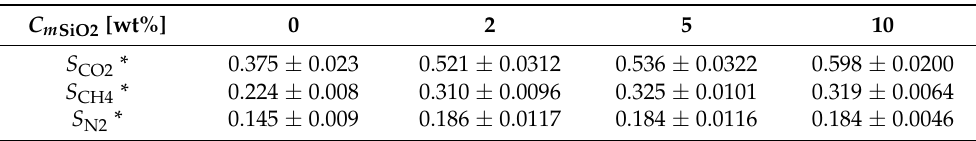
Table A7. Solubility coefficient S i for membranes of different SiO 2 concentrations. * The values in table should be multiplied.